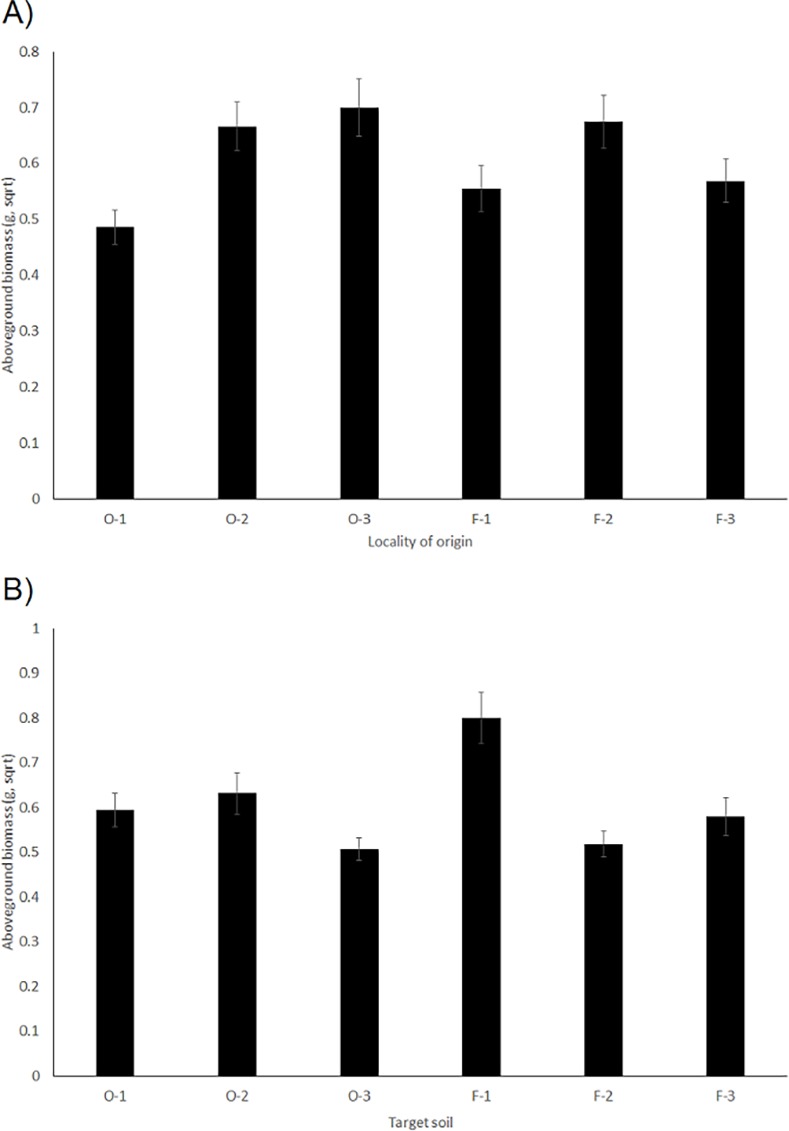
The effect of A) locality of origin and B) target soil on plant aboveground biomass of A. ramosum in the common garden experiment.O indicates A) open environment of origin and B) soil from open environments, F indicates A) forest environment of origin and B) soil from forest environments. Numbers denote locality numbers and correspond to Fig. 1.